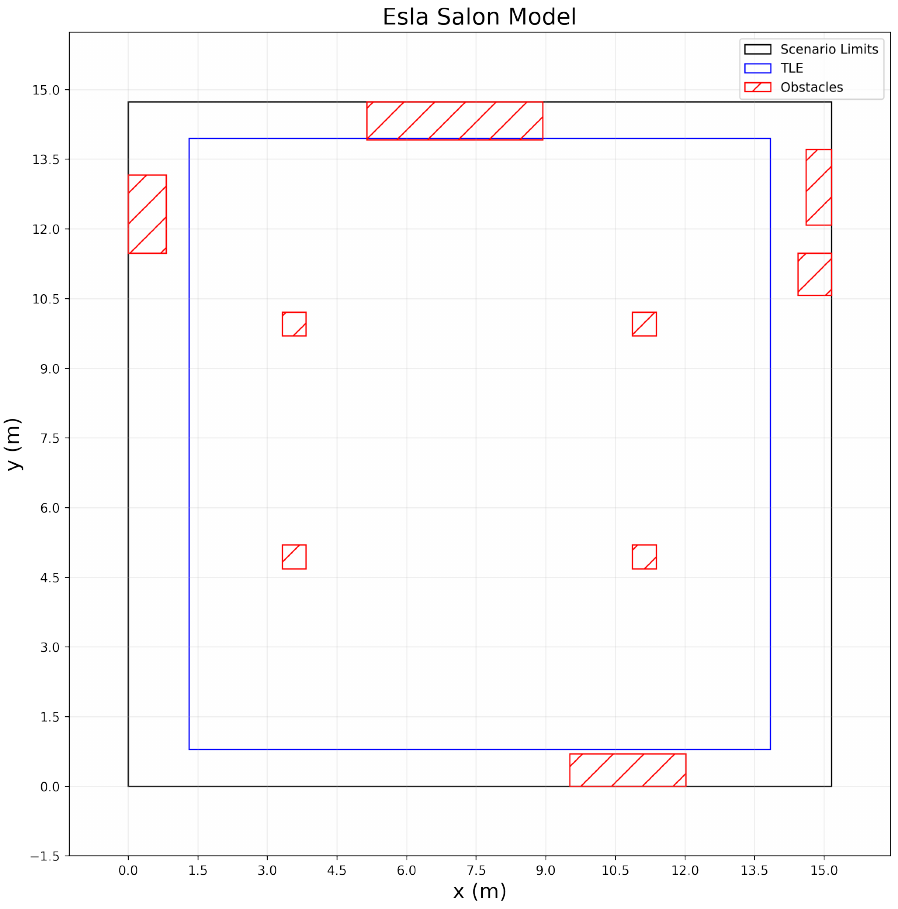
Figure 4. Model of the Esla Salon without the Table